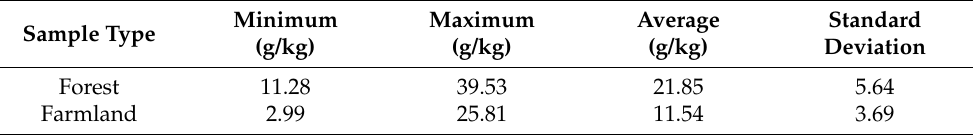
Table 7. Descriptive statistics of predicted SOC content using the RF and XGBoost models for forest and